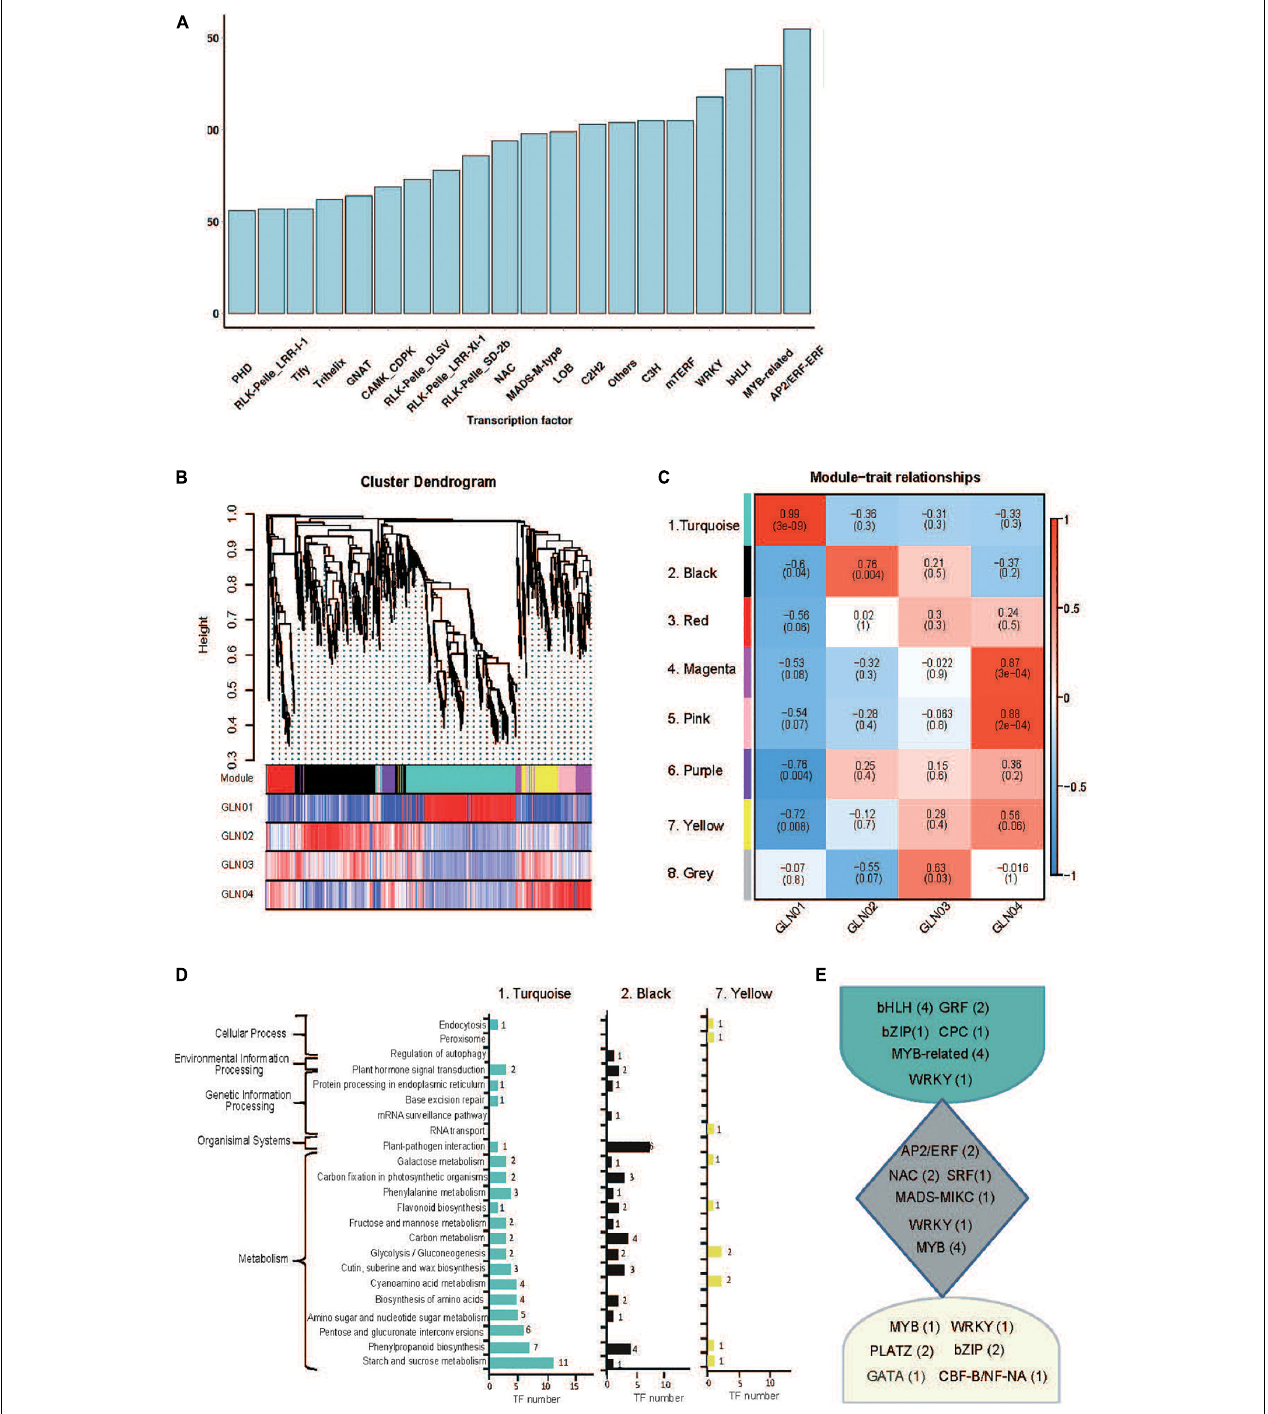
FIGURE 4 | Identification of TFs and results of WGCNA analysis. (A) A partial list of TFs (top 20 gene families) identified in 12 full-length transcriptome of G. luofuense stems. (B) Hierarchical clustering tree showing co-expression modules based on WGCNA analysis. Each branch in the phylogenetic tree corresponds to an individual TF, and highly interconnected TFs are grouped into eight modules. The different colored rows below the phylogeny indicate differentially expressed TFs in G. luofuense . (C) A heatmap of TF expression patterns in a matrix shows module–trait relationships. The expression patterns of eight modules are shown by the heatmap with a color bar of expression levels from high (red) to blue (red). The correlation coefficient was present for each cell, with the subtended by values of –log( P ), where P is the Fisher’s exact test P value. (D) KEGG pathway annotations of TFs in the largest three modules. (E) Highly expressed TFs and numbers in brackets in the largest three